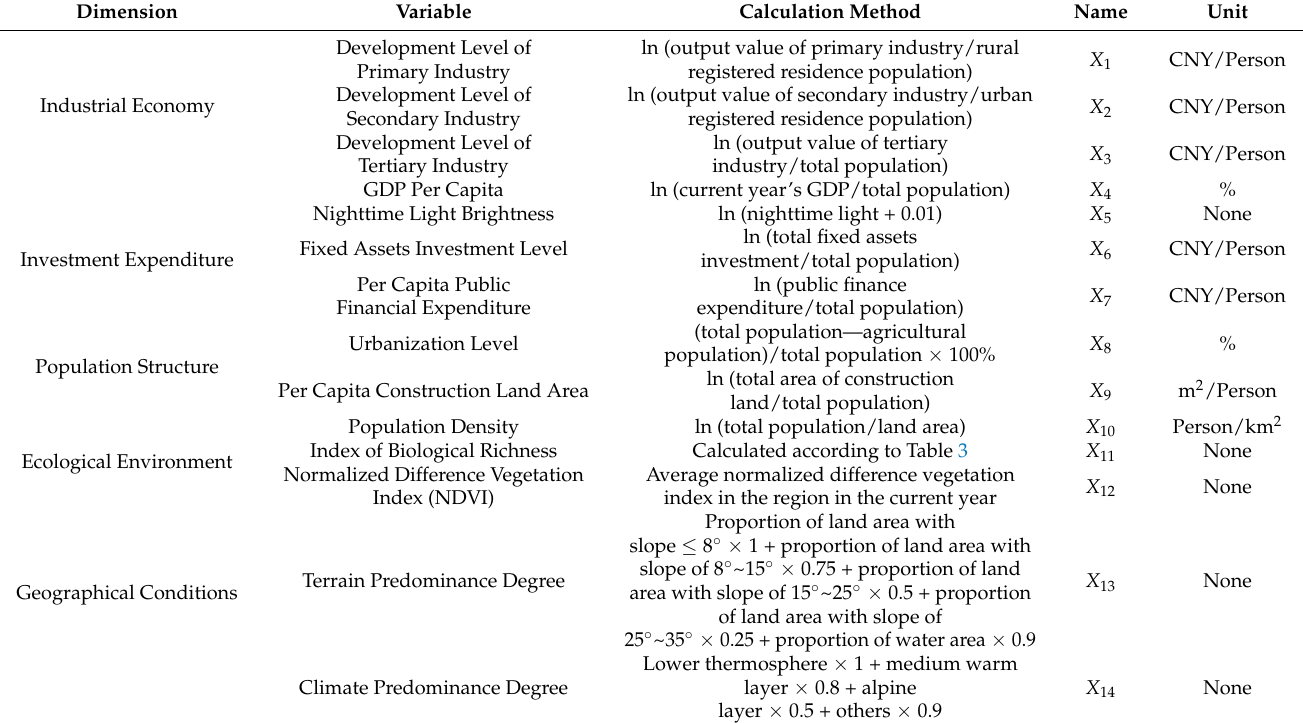
Table 5. Index System and Calculation Method of Influencing Factors.